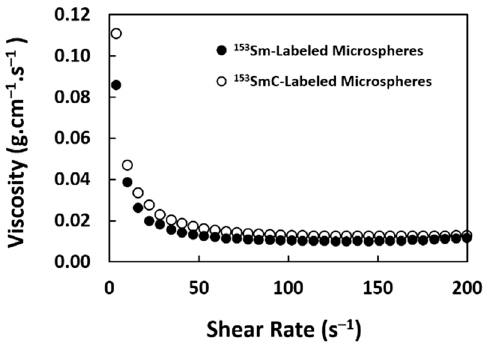
Figure 7. Viscosity of 2.5% w / v suspension of 153 Sm- and 153 SmC-labeled microspheres in saline at 37 °C with various shear rates.